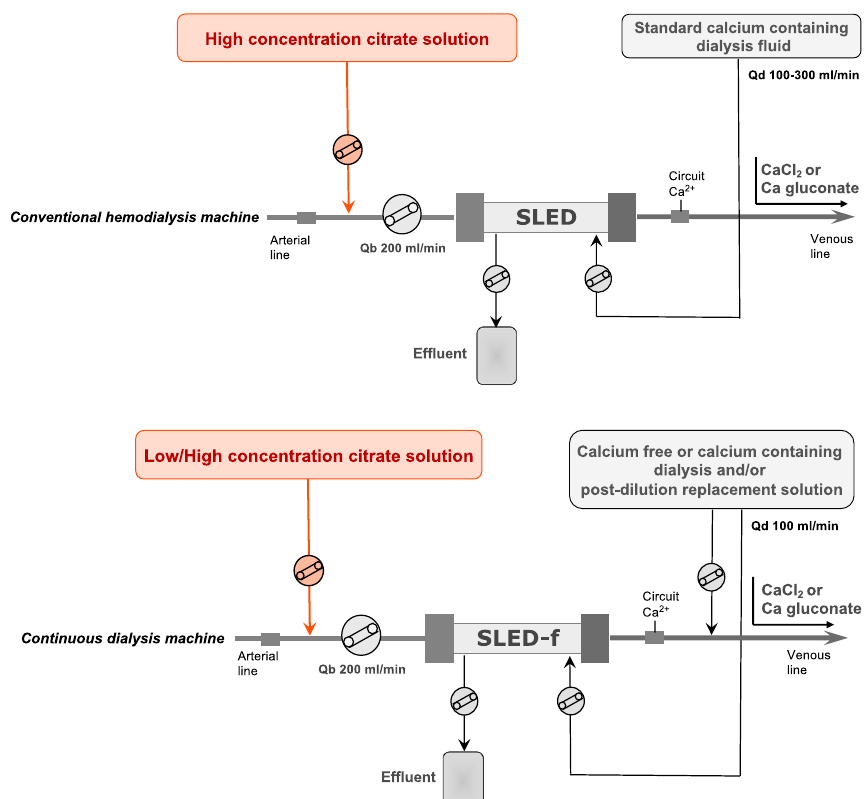
Fig. 2 Simplified PIRRT circuits with RCA for SLED and SLED-f, variably applied with any conventional hemodialysis or CRRT machine. Abbreviations: PIRRT, prolonged intermittent renal replacement therapy; RCA, regional citrate anticoagulation; SLED, sustained low efficiency dialysis; SLED-f, sustained low efficiency dialysis filtration; Qb, blood flow rate; Qd, dialysis flow